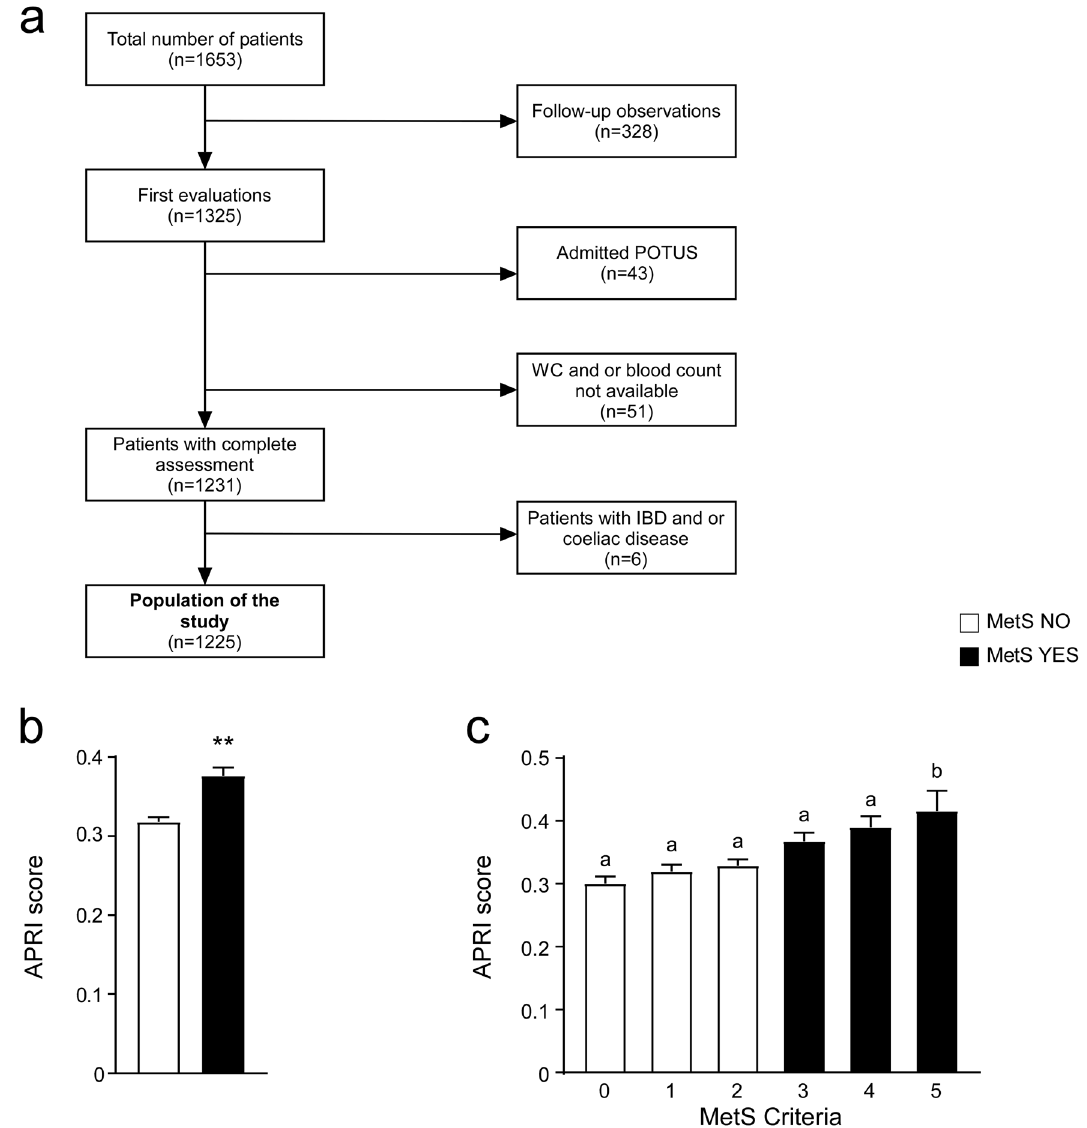
Figure 1. Flowchart of study population and graphic representation of APRI score values. ( a ) Flowchart of the study population. ( b ) T-Test comparison of entire study population. Subjects categorized based on Metabolic Syndrome (MetS) diagnosis; non-metabolic (MetS NO) subjects = n.685, MetS (MetS YES) patients = n.540. Data is presented as mean ± SEM; **p < 0.01. ( c ) Comparison of APRI levels. Subjects were categorized based on positivity for MetS criteria. 0 criteria = n.186, 1 criterion = n.240, 2 criteria = n.259, 3 criteria = n.283, 4 criteria = n.171, 5 criteria = n.86. Data is presented as mean ± SEM. Comparison of groups was performed using one-way ANOVA test followed by Bonferroni’s post-hoc test. Data from groups sharing the same lowercase letter were not significantly different, whereas data from groups with different case letter were significantly different (p <